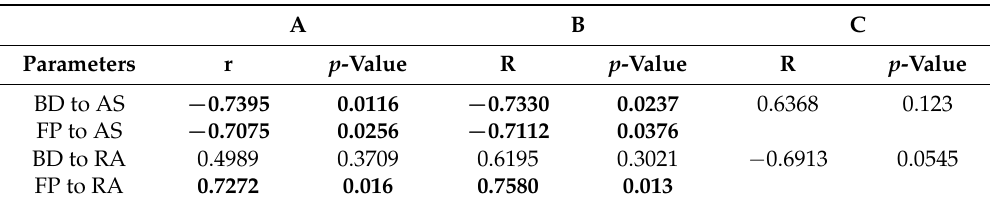
Table 4. Pearson correlations of bacterial densities on Z. marina (BD) and on glass slides (FP) with the mean activity strength of Z. marina surface extracts against bacterial isolates (AS) and the rosmarinic acid concentration (RA) in these extracts. In (A), bacterial densities were correlated with AS and RA in extracts sampled in the same month. In (B), bacterial densities were correlated with AS and RA in extracts sampled one month later (=lagged responses). In (C) BD was the lagged response and correlated with AS and RA in extracts sampled one month earlier. Bold types indicate significant correlations ( p <